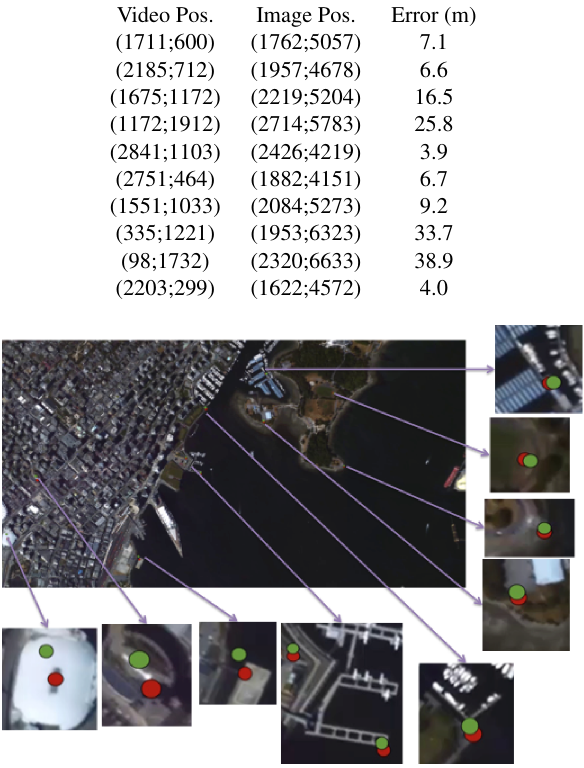
Table 1. Indirect geo-referencing of the video frame, from landmark recognition.